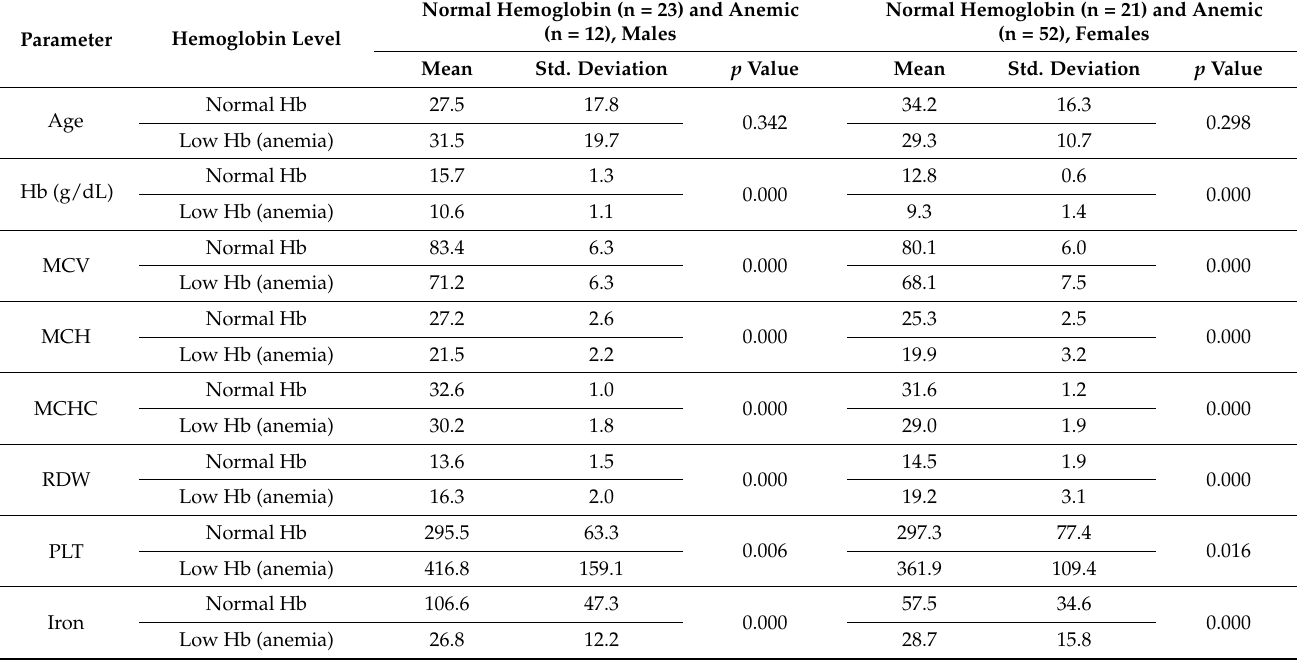
Table 1. Clinical parameters of normal individuals and anemic patients by